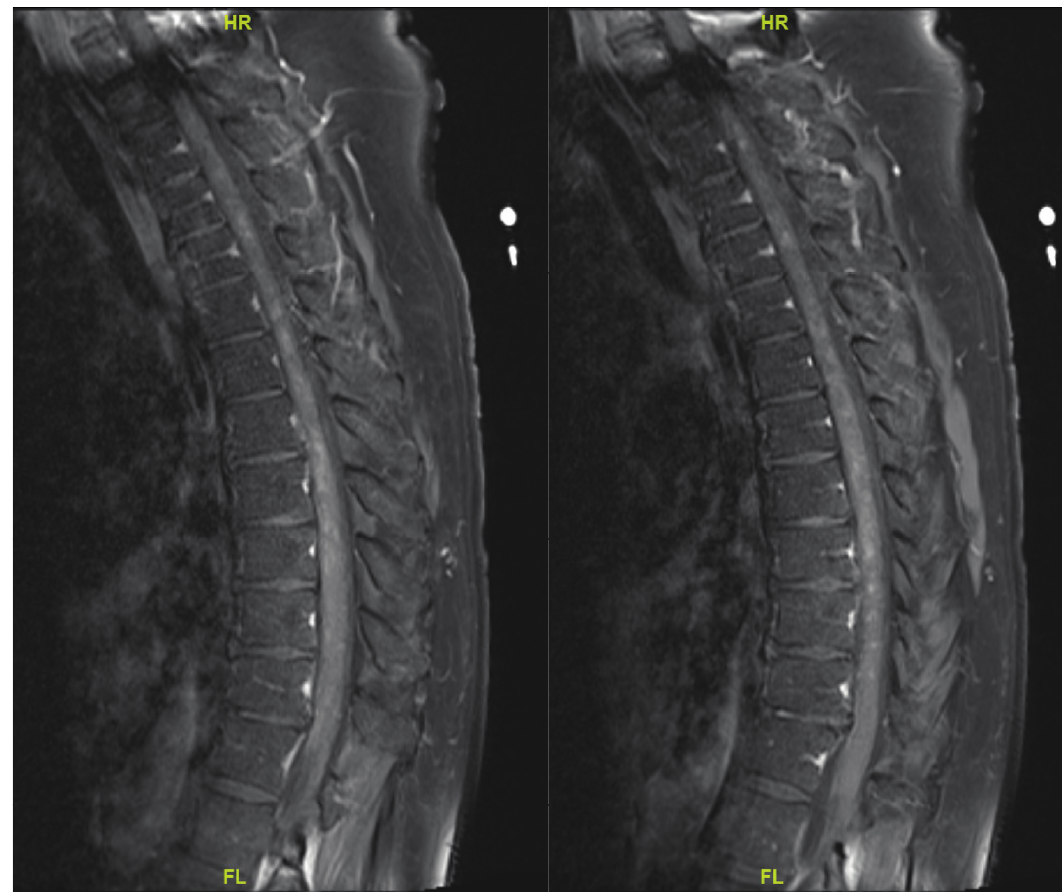
Figure 1: MRI spine T1-weighted sagittal images showing contrast